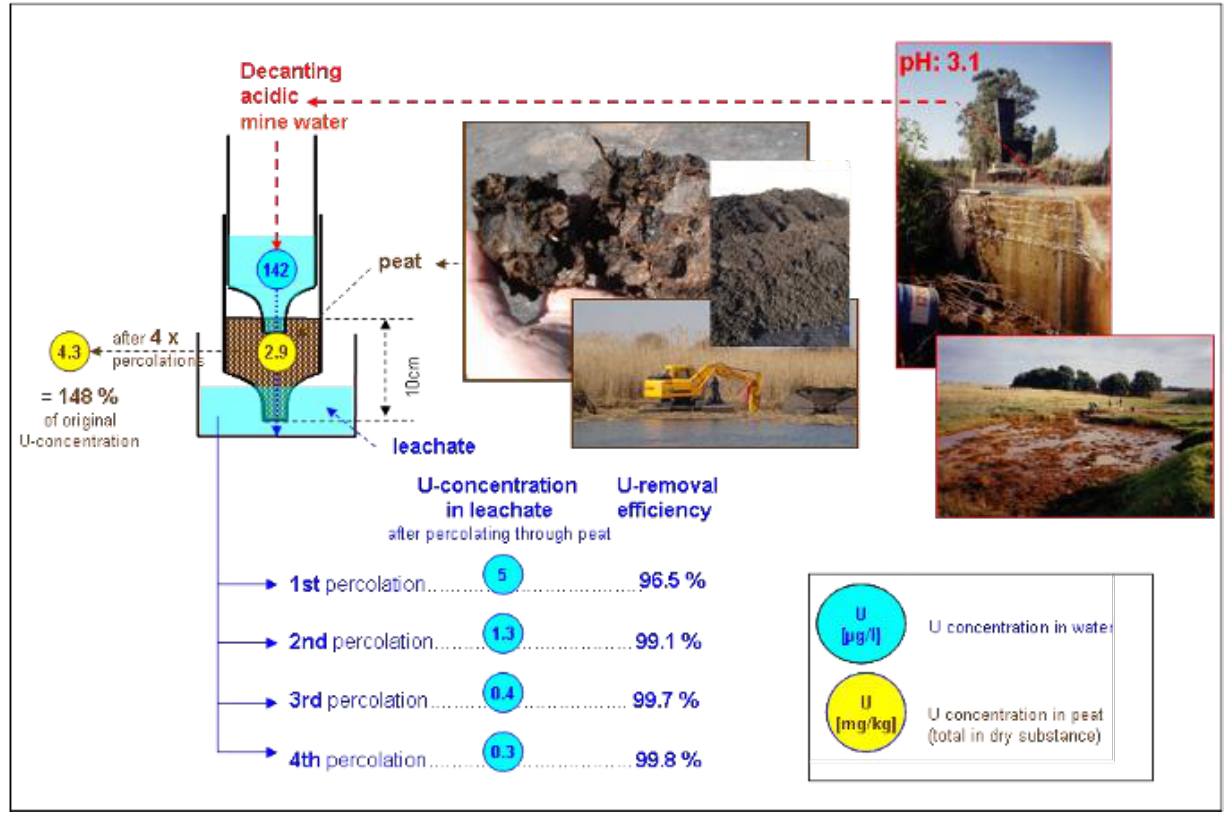
Figure 16. Removal efficiency of peat from the GMB wetland for U contained in acid mine water currently decanting from a flooded mine void in the Western